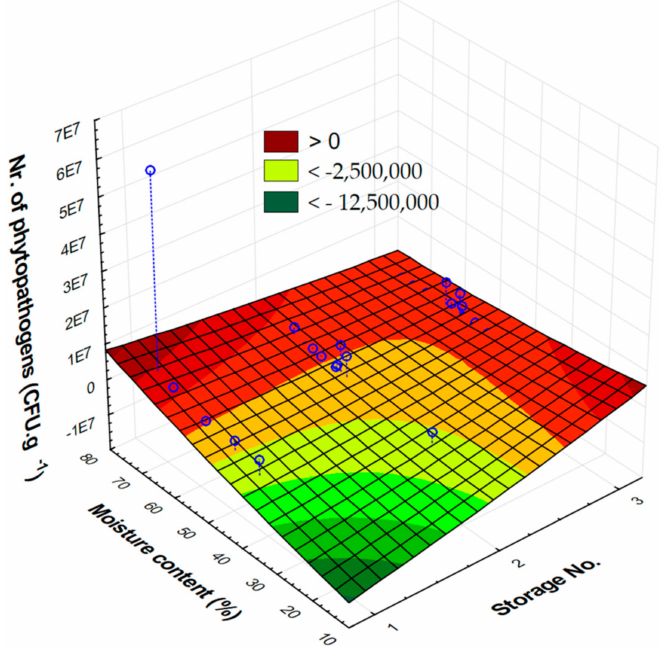
Figure 3. The number of colonies of phytopathogens per 1 g depending on the moisture content of the samples and the place of collection.